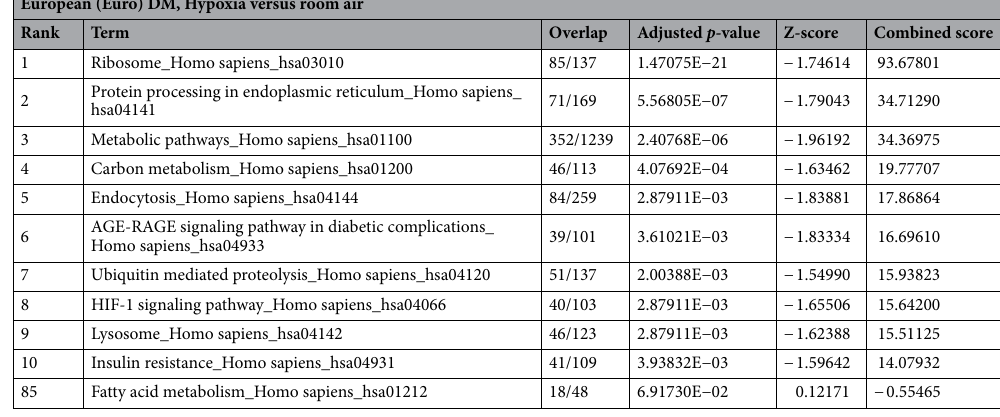
Table 2. EnrichR pathway analysis of differentially-expressed genes between Euro/DM cybrids cultured in room air versus 2% oxygen. The top 10 pathways, along with others that are much more differently ranked between the Euro/DM and [Afr + Asi]/DM comparisons are listed.